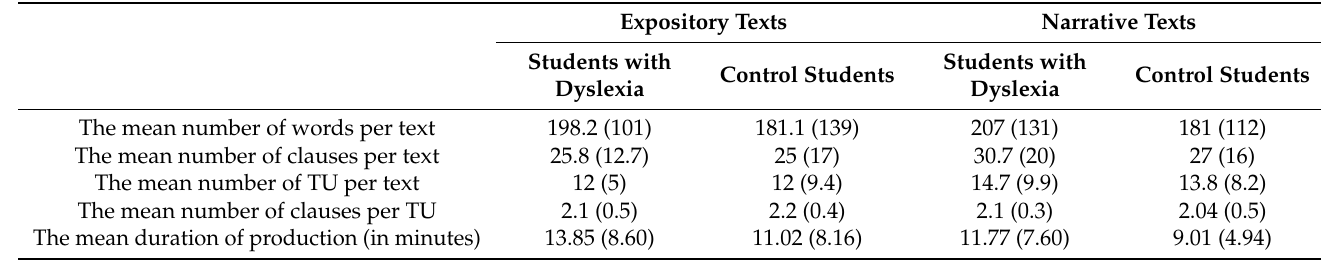
Table 3. Length indicators for written texts according to text type and